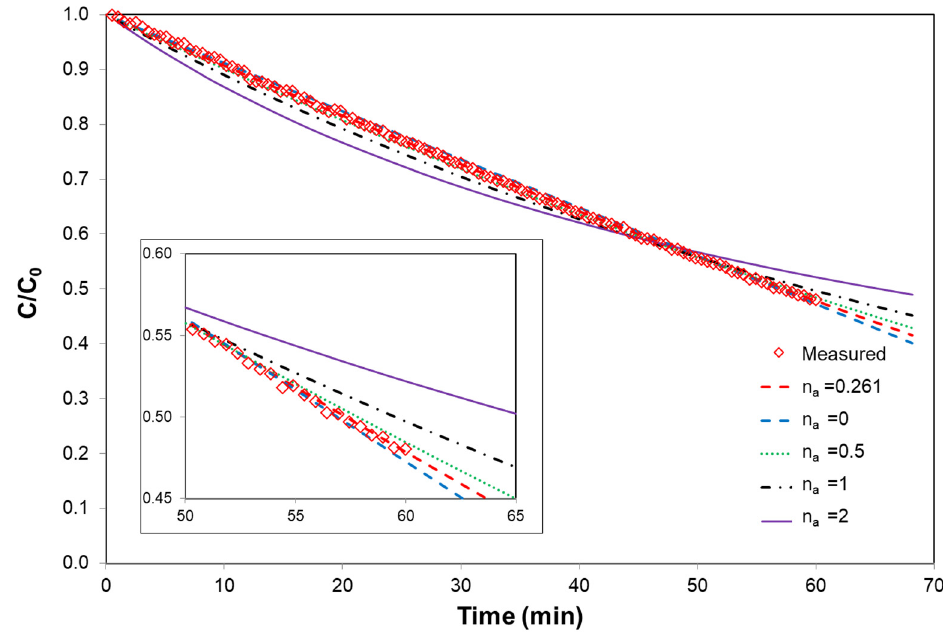
Figure 2. Photocatalytic degradation of 20 μ M ofloxacin in the presence of 0.2 mg L − 1 TiO 2 . Red squares represent measured values, whereas lines represent different calculated amounts using Equations (2) and (3) and optimized kinetic coefficient parameters (see Table 1). Inset emphasizes fits and differences close to t 1/2 = 57.1 min.